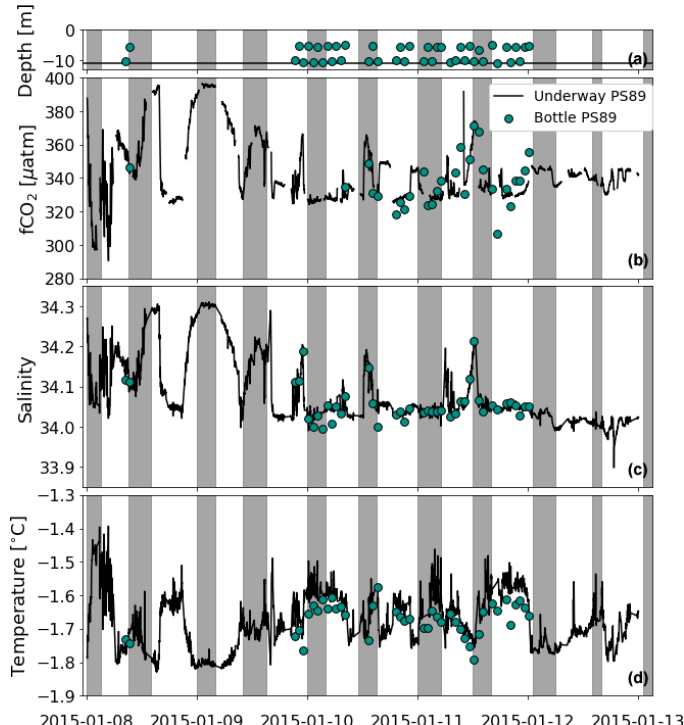
Figure D1. A comparison of measurements between the continuous measurements from the on-board underway system and the discrete samples of the surface seawater for PS89. (a) Depth at which the surface discrete samples were collected during the tidal observation. The horizontal black line indicates depth at 11m, which is the depth of the intake for the continuous f CO 2 measurements. (b) The f CO 2 continuous measurements from the on-board underway system (black line) and the calculated f CO 2 from the discrete surface samples (circles). Panel (c) is the same as (b) but for salinity. Panel (d) is the same as (b) but for temperature. The grey areas indicate periods of ebbing tide (where the u and v components of the modelled tidal currents are both